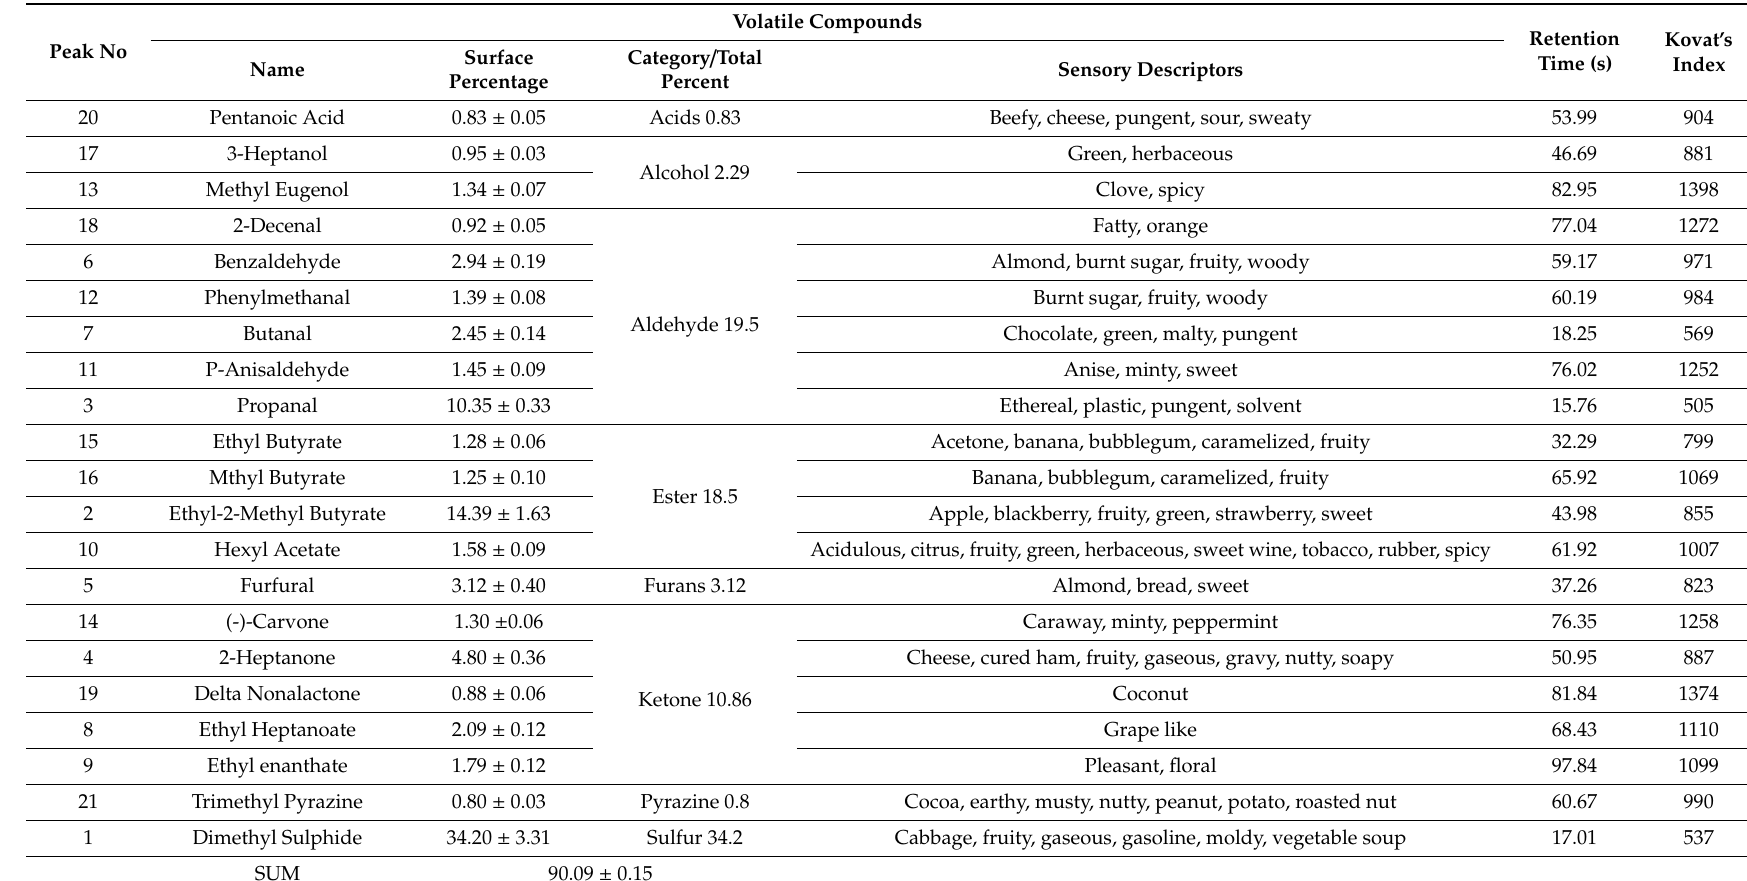
Table 5. Headspace volatile compounds of soybean variety: